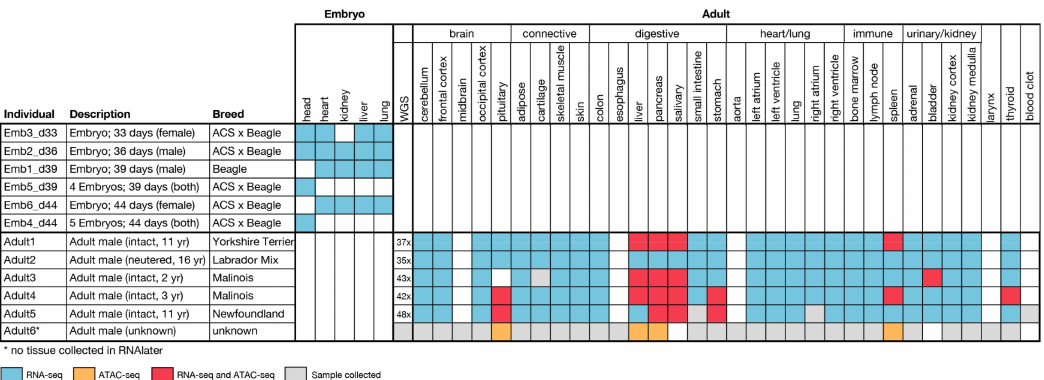
Figure 1. BarkBase sample collection and data production. Samples were collected from a total of six embryos, and six adult dogs. BarkBase currently contains RNA-seq data from up to five tissues in d33, d36, d39, and d44 embryos, and from up to 27 tissues sampled from each of five adult dogs diverse in age and in breed ancestry. ATAC-seq data are currently available for eight tissues from a subset of individuals. Additional data sets will be posted as they become